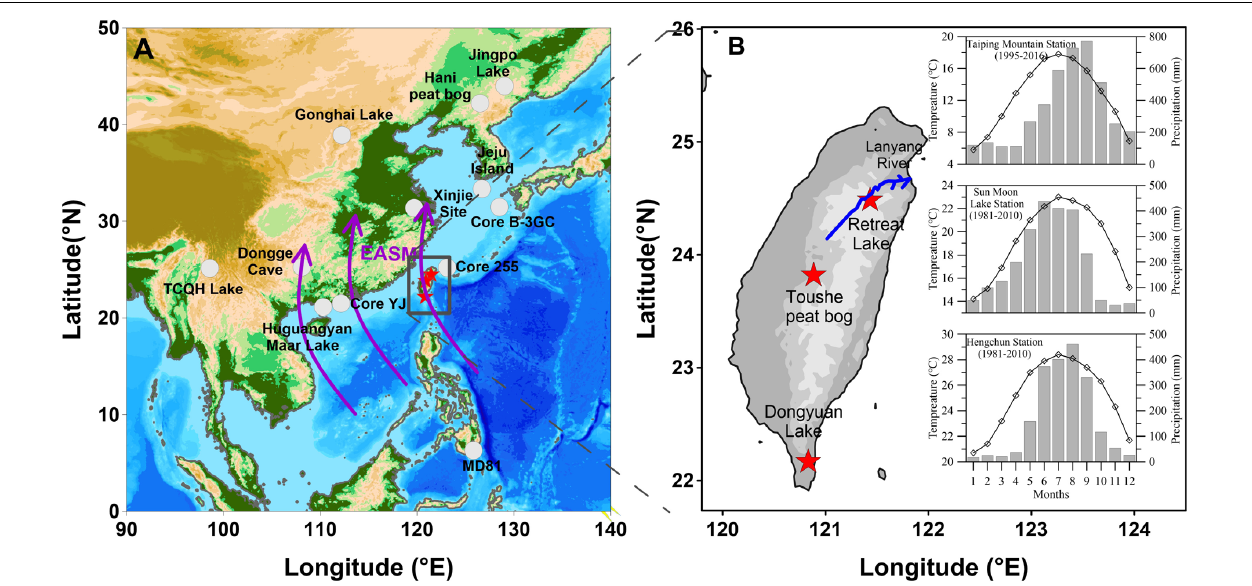
FIGURE 1 | (A) Locations of the climate records synthesized and discussed in this study. (B) Mean monthly temperature and precipitation in the meteorological stations near the three lakes and peat bog are provided (Taiping Mountain Station for Retreat Lake, Sun Moon Lake Station for Toushe peat bog and Hengchun Station for Dongyuan